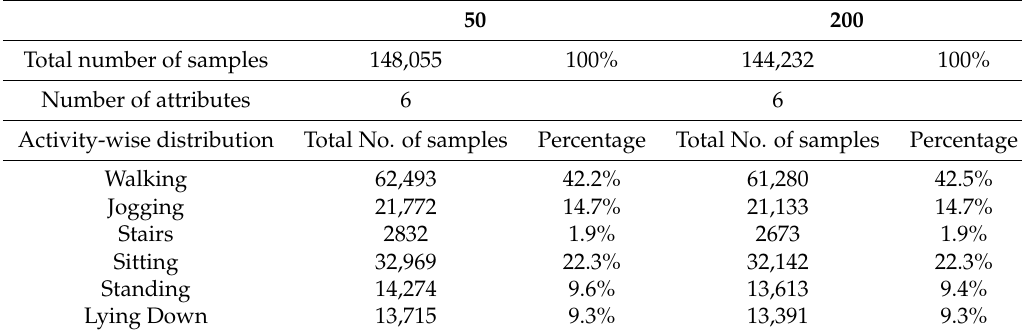
Table 5. Windowed Actitracker dataset